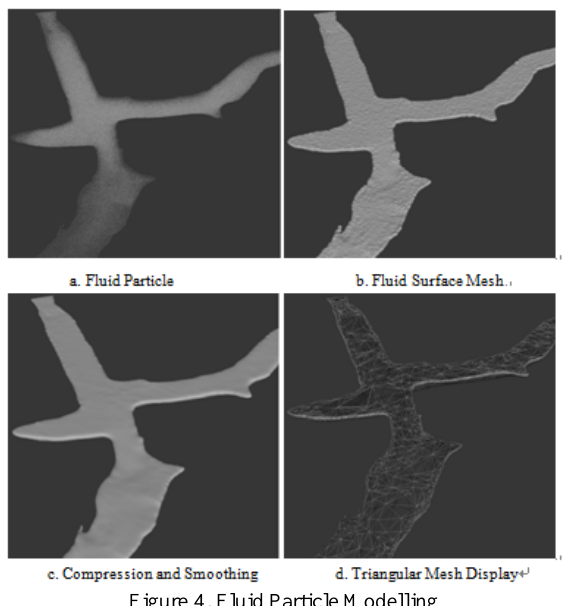
Figure 4. Fluid Particle Modelling